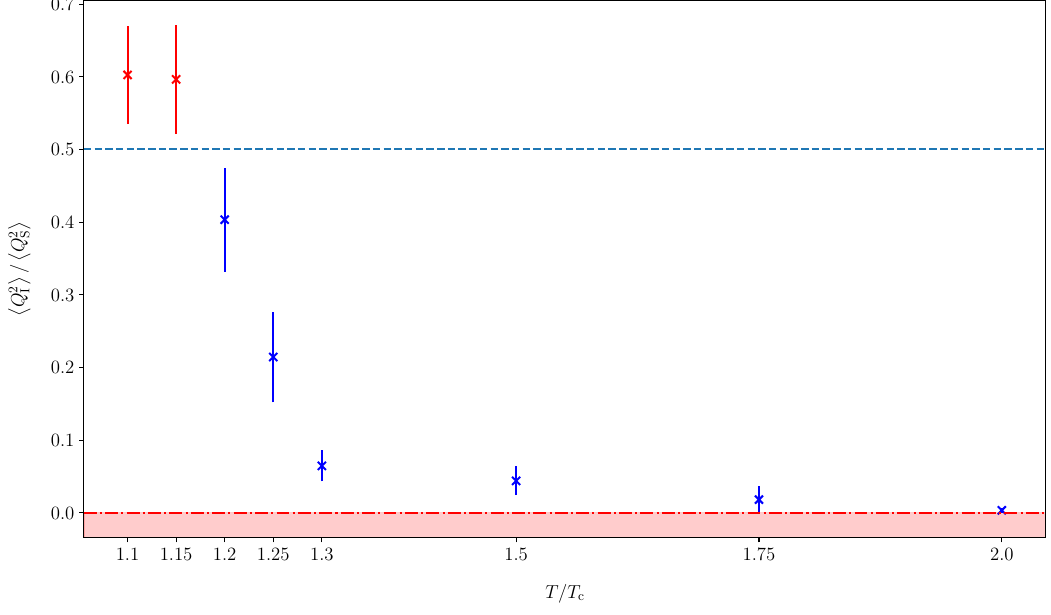
Figure 13 . Ratio between the amount of instantons ( Q I 6 = 0 ) and sphalerons ( Q S 6 = 0 ) as a function of temperature (in T c units). Only the sphaleron rate has been extrapolated to zero gradient-flow- depth, as described in the previous